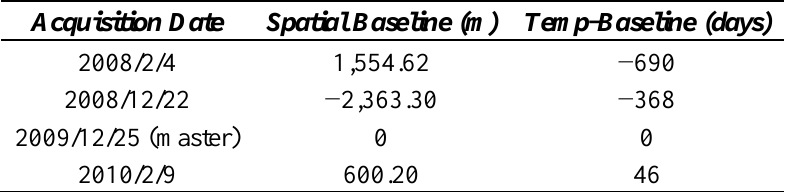
Table 2. Specifications of ALOS data